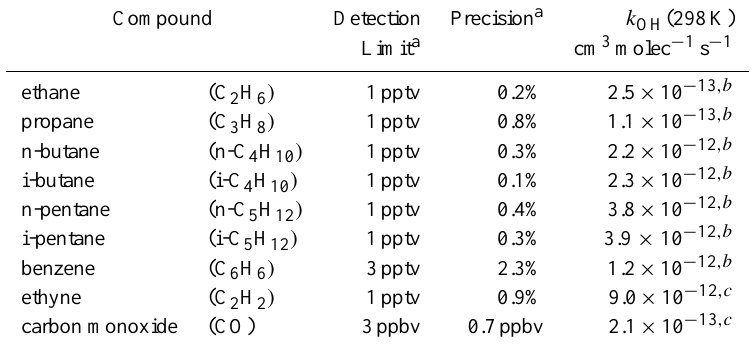
Table 1. Analytical information and rates of reaction with hydroxyl radical ( k OH ) for non-methane hydrocarbons considered in this work.